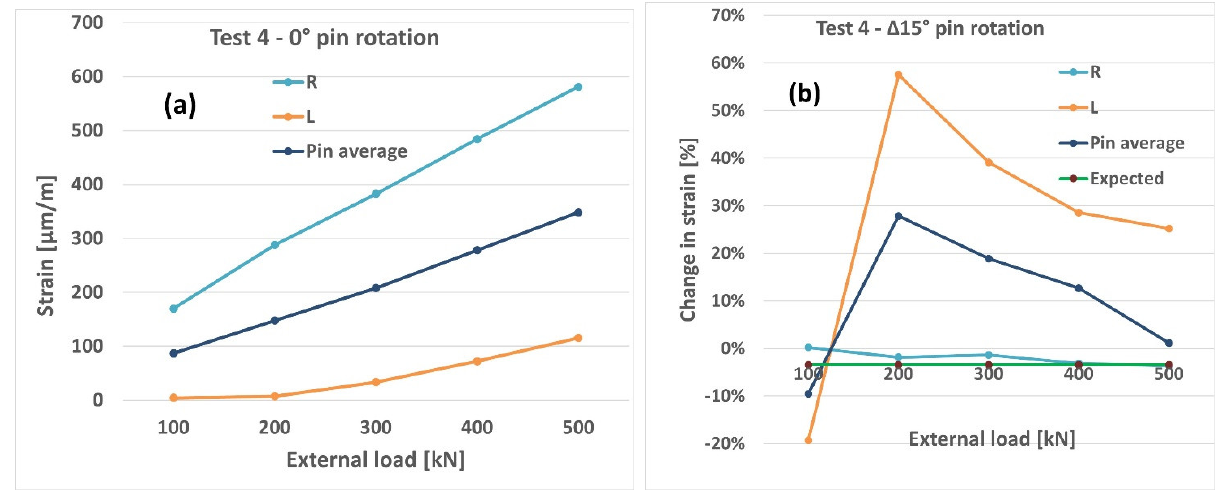
Figure 12. Test 4, ( a ) strains at 0° position, ( b ) percentage change of strains from 0° to 15° position.